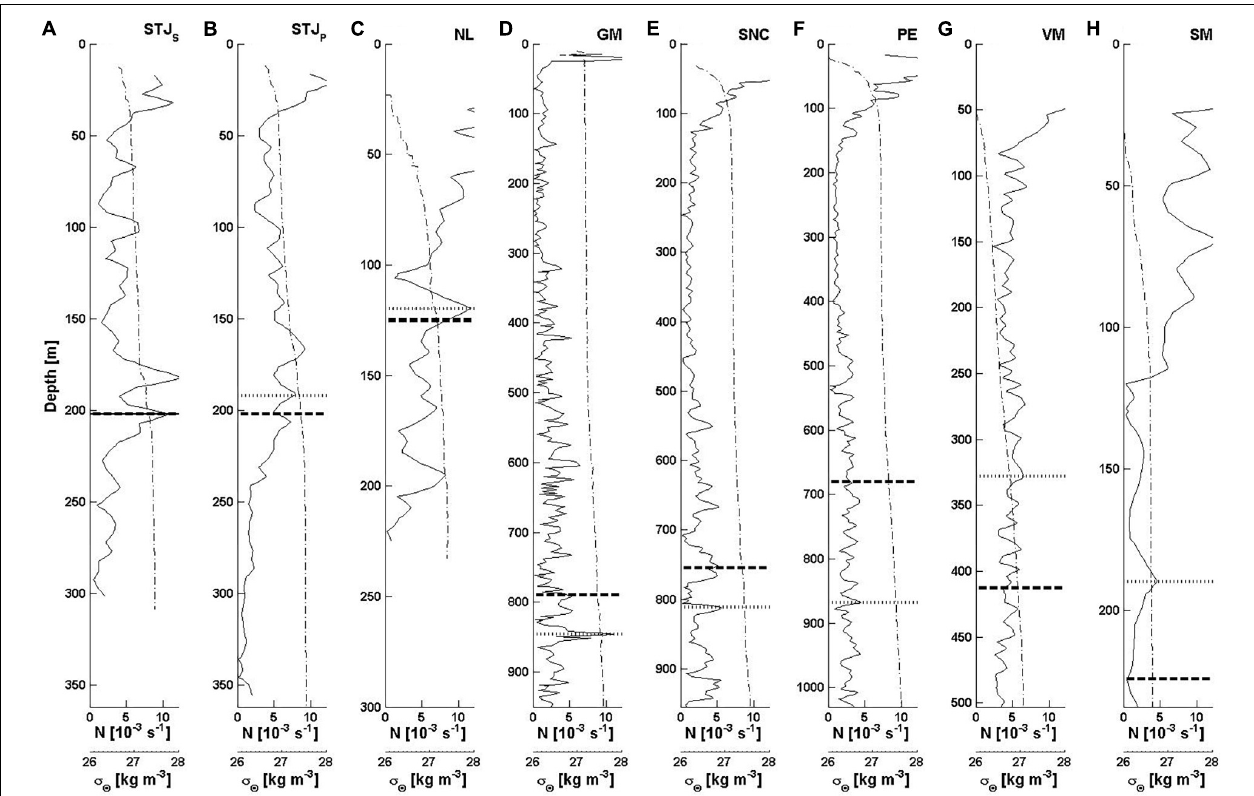
FIGURE 6 | Water column stratification, N (solid thin line), and sigma-theta, σ (cid:50) (dash-dot thin line), for (A) STJ S , Stjernsund CWCs; (B) STJP, Stjernsund reference; (C) NL, Nordleksa; (D) GM, Galway Mound; (E) SNC, St. Nazaire Canyon; (F) PE, Pagés Escarpment; (G) VM, Valentine Mound; and (H) SM, Sylvester Mound. The deep layer stratification maximum (dotted thick line) and summit depth of the morphologic structure (dashed thick line) show the depths (h 1 , h 2 and b m ) used in the analysis. At STJ S only one line is shows, because the stratification maximum and the summit depth coincide. Note that the scale of the y -axis varies from the surface to the base depth of the morphologic structure. The displayed ranges are N = 0–12 × 10 − 3 s − 1 and σ (cid:50) = 26–28 kg m − 3 .